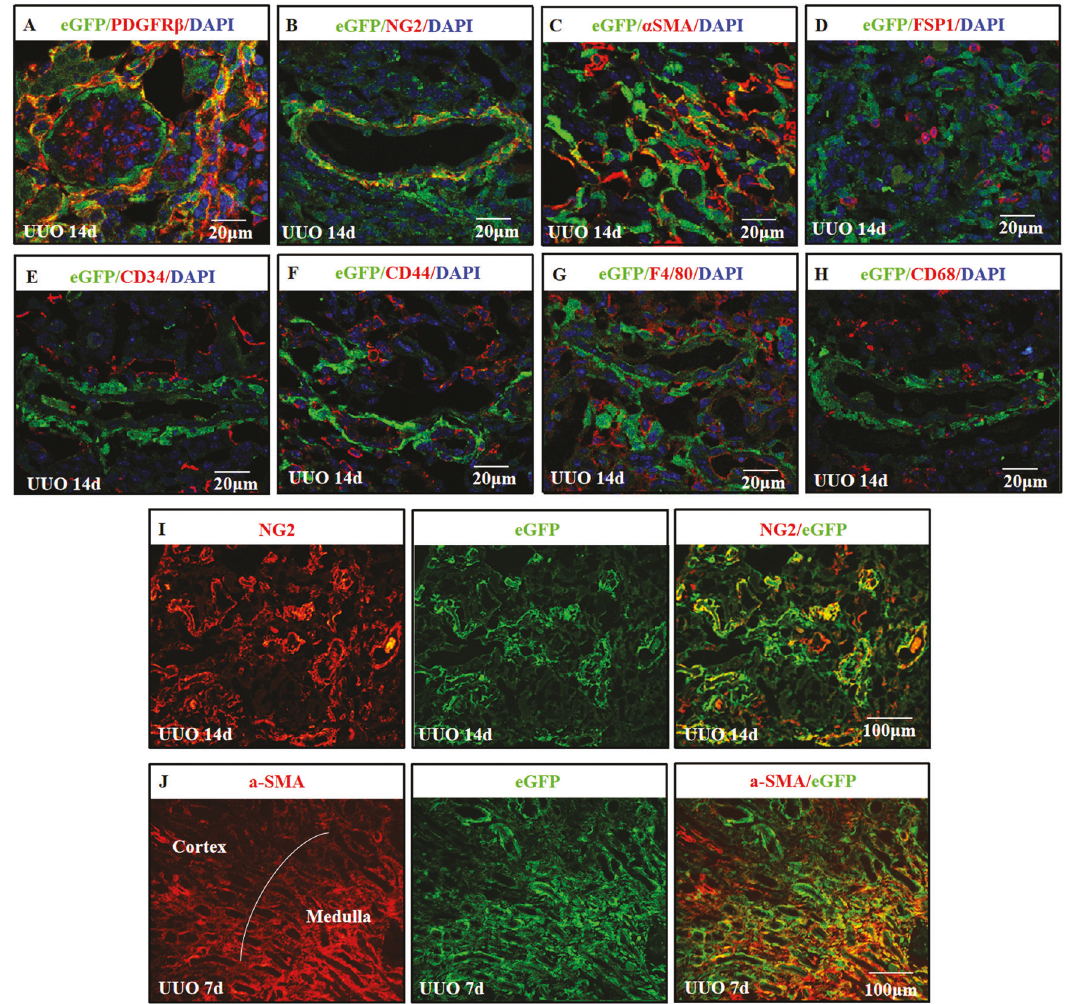
Fig. 9 TNC-expressing cells in fi brotic kidneys were mostly PDGFR β + NG2 + fi broblasts. In TNC CreER2-eGFP/ + reporter mice, eGFP positive cells were all PDGFR β positive, consistent with stromal cells ( A ). Most of the eGFP-positive cells were also NG2 (a marker of pericyte) positive ( B , I ). Some of eGFP positive cells were α SMA positive, while most of α SMA positive myo fi broblasts were not eGFP positive ( C , J ). These eGFP- positive cells were not positive for FSP1 ( D ). They were neither CD34 nor CD44 positive progenitors ( E , F ), and were neither CD68 nor F4/80 positive ( G , H ). ( n = 4, 3 sections for